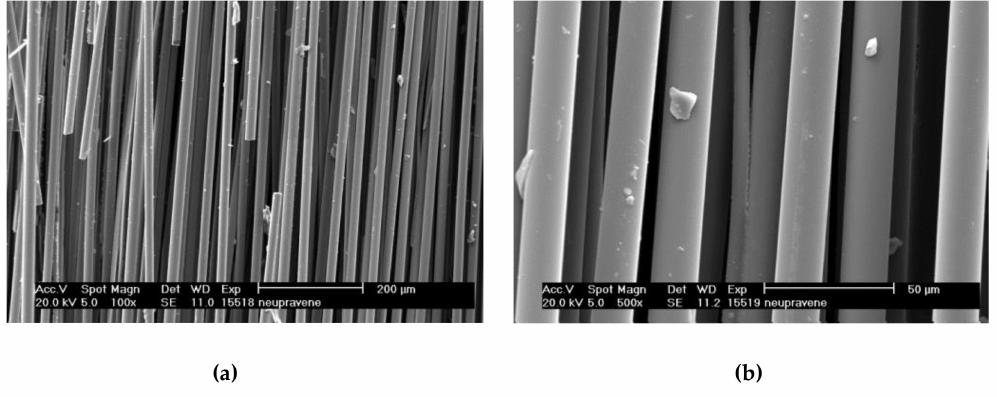
Figure 15. ( a ) Scanning electron microscope (SEM) micrograph of fractured composite beam for weaker interfacial adhesion between the GFs and the polyester resin; ( b ) detailed view.